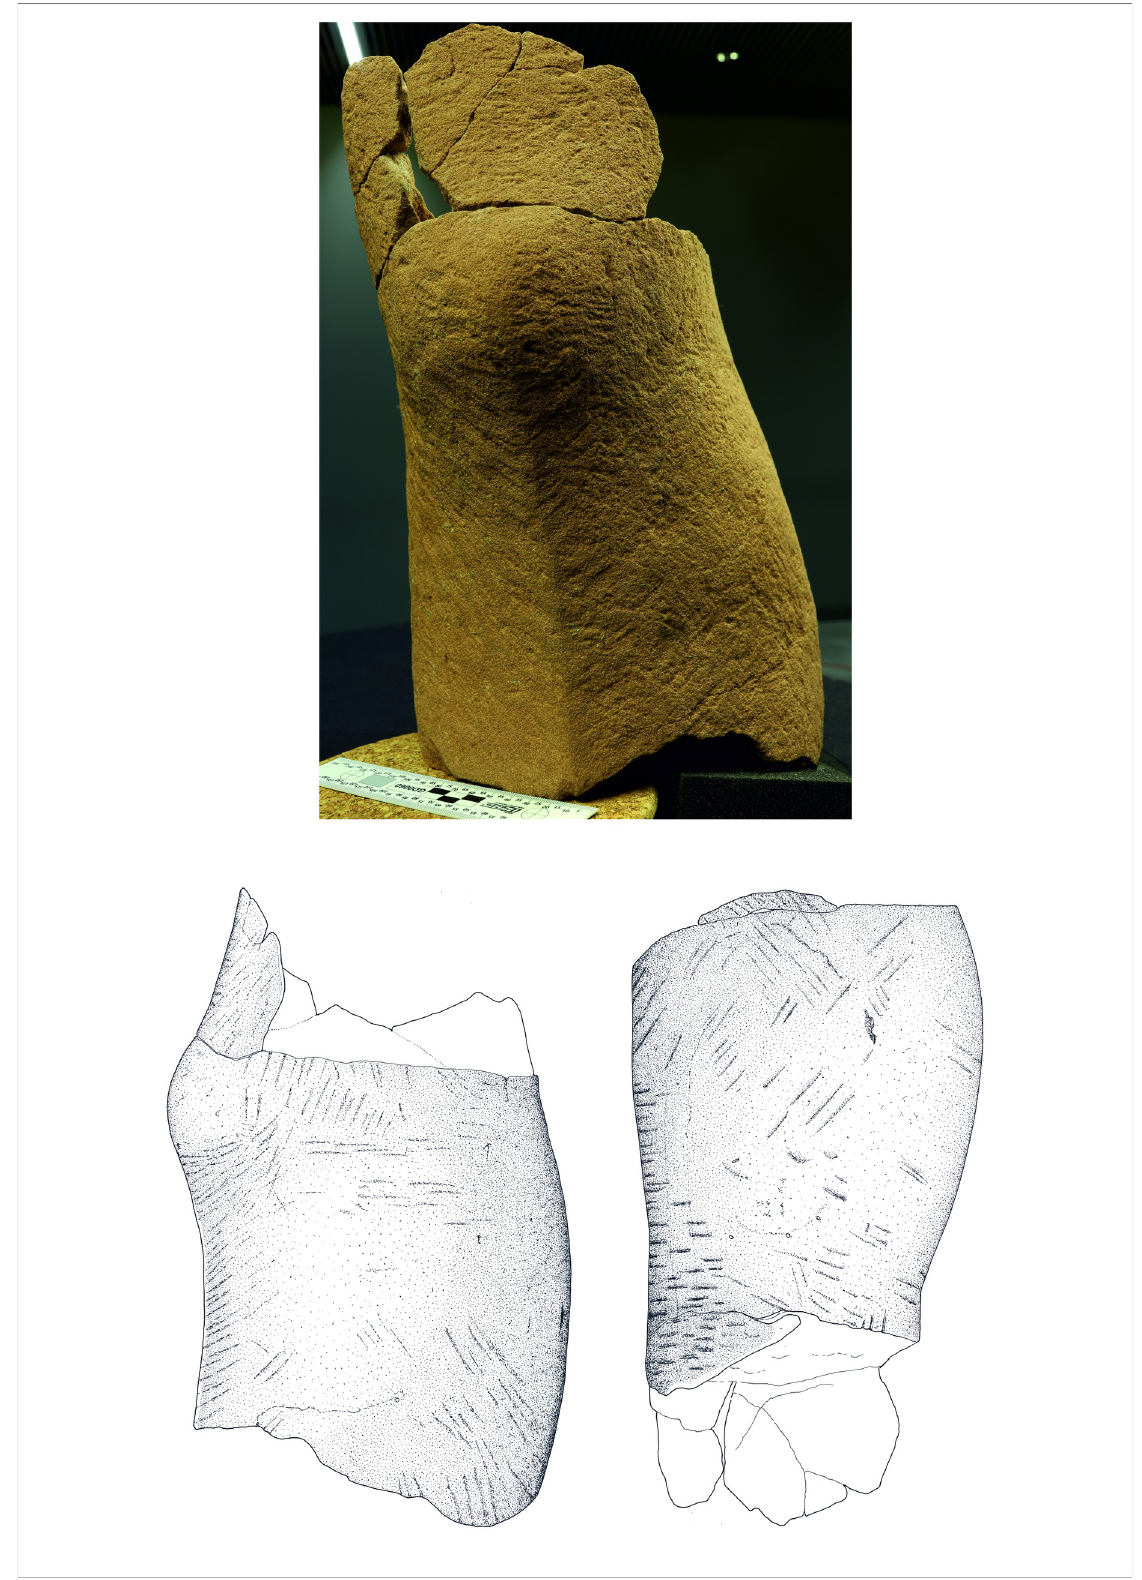
Fig 3. Fragment (leg) of a sandstone statue (statue 2) from the Glauberg (photo: F. R. Va´clavı´k; drawing: Pilar Rispa). https://doi.org/10.1371/journal.pone.0271353.g003 PLOS ONE | https://doi.org/10.1371/journal.pone.0271353 August 11,